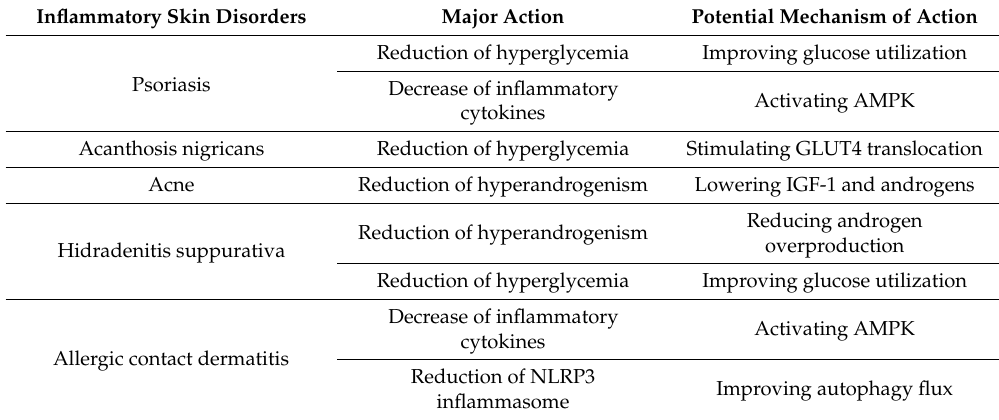
Table 1. The potential mechanisms of action of metformin in inflammatory skin